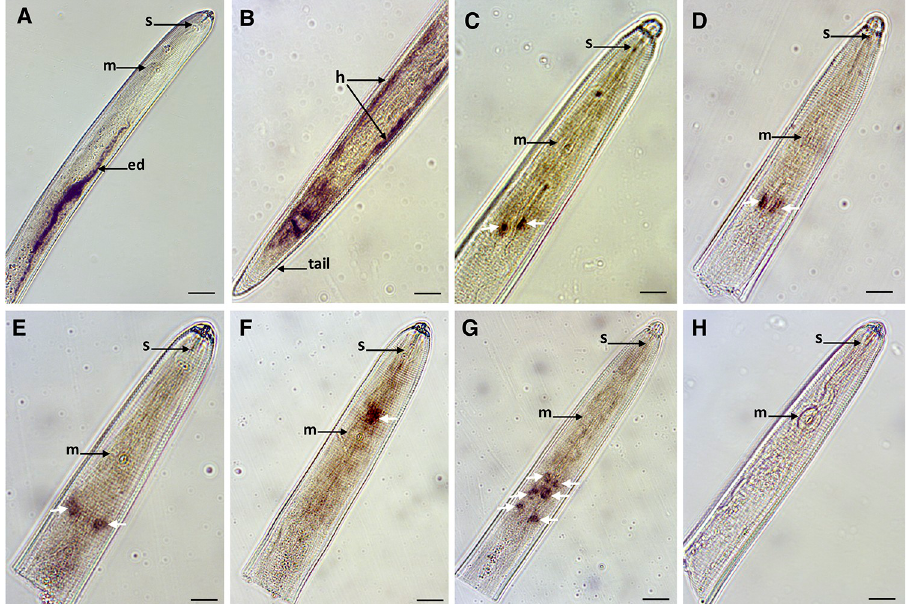
Fig 4. Detection of gene transcripts encoding putative secreted proteins and localized in different Radopholus similis tissues by in situ hybridization. (A) g9088.t1, (B) g1157.t1, (C) g12860.t1, (D) g12895.t1, (E) g5235.t1, (F) g11460.t1 and (G) g13141.t1. White arrows in images C-G indicate “cell-like bodies” along the anterior region of the nematode. (H) Example of a control image obtained using the sense probe (e.g. g9088.t1). (ed): excretory duct; m: median bulb; s: stylet. Bars = 20 μ m.